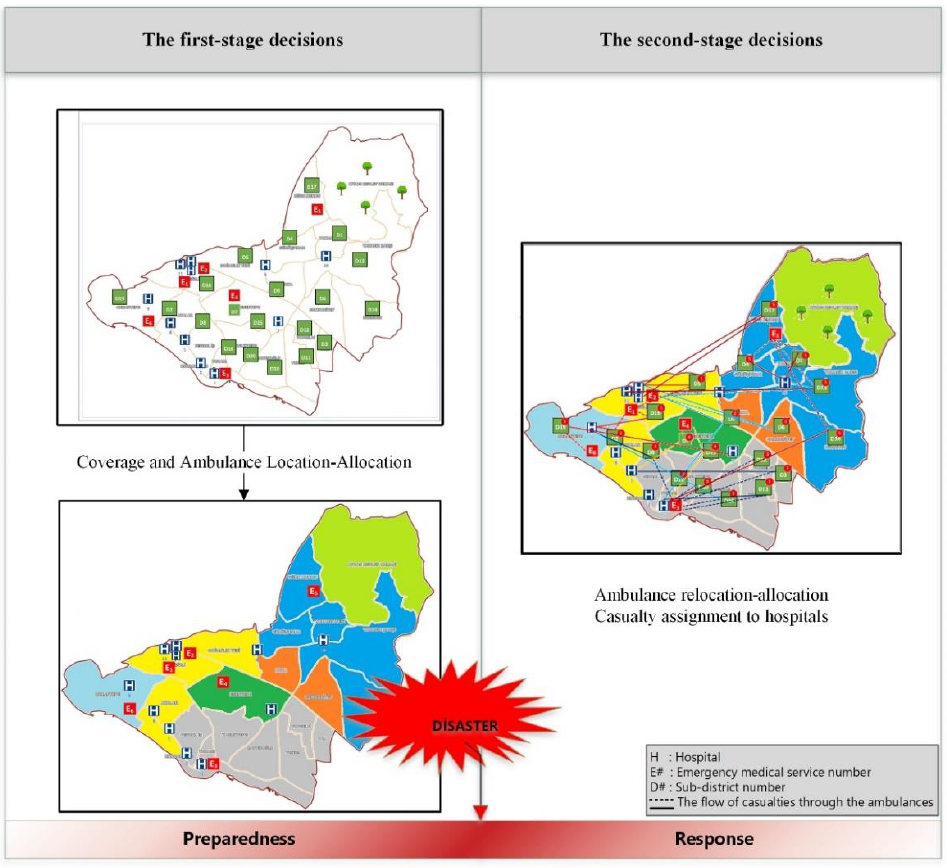
Figure 3. The structure of the proposed stochastic programming model on Kartal map.